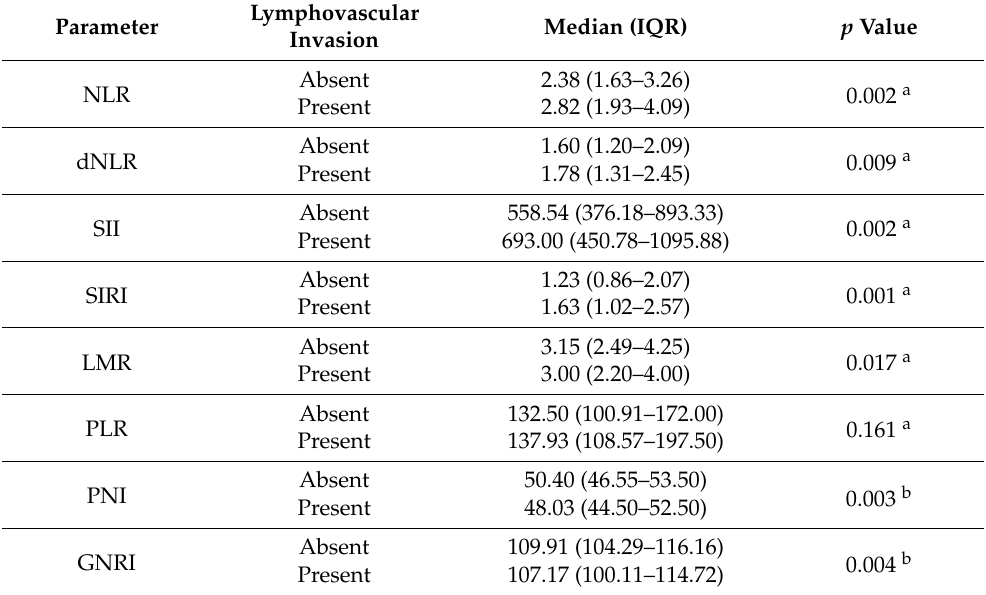
Table 6. Associations of inflammatory and nutritional parameters with the presence of lymphovascu- lar invasion.